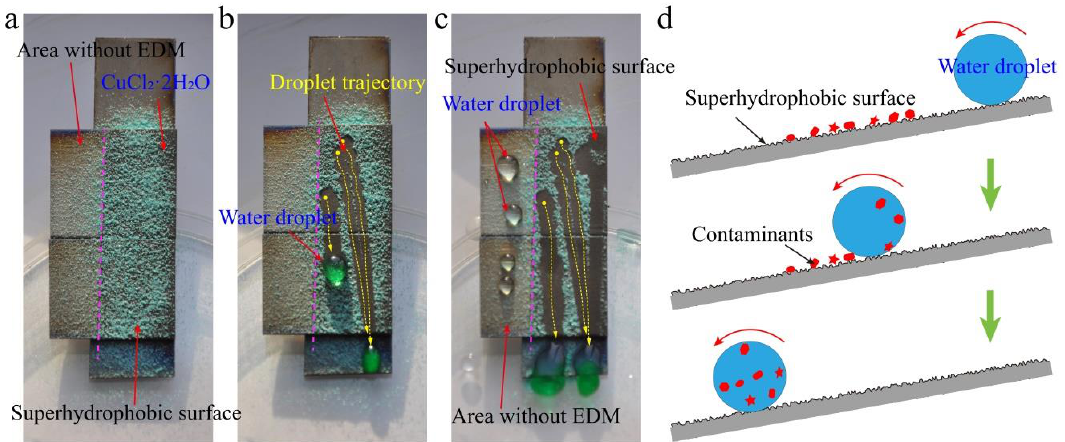
Figure 11. Self-cleaning performance of the as-prepared superhydrophobic surface. ( a ) Artificial dirt (CuCl 2 · 2H 2 O) spread on the as-prepared superhydrophobic surface. ( b ) Dirt taken away from the as-prepared superhydrophobic surface by the rolling off of water droplets. ( c ) Comparison of the self-cleaning performance on different surfaces. ( d ) Mechanism of the self-cleaning process of the as-prepared superhydrophobic surface .